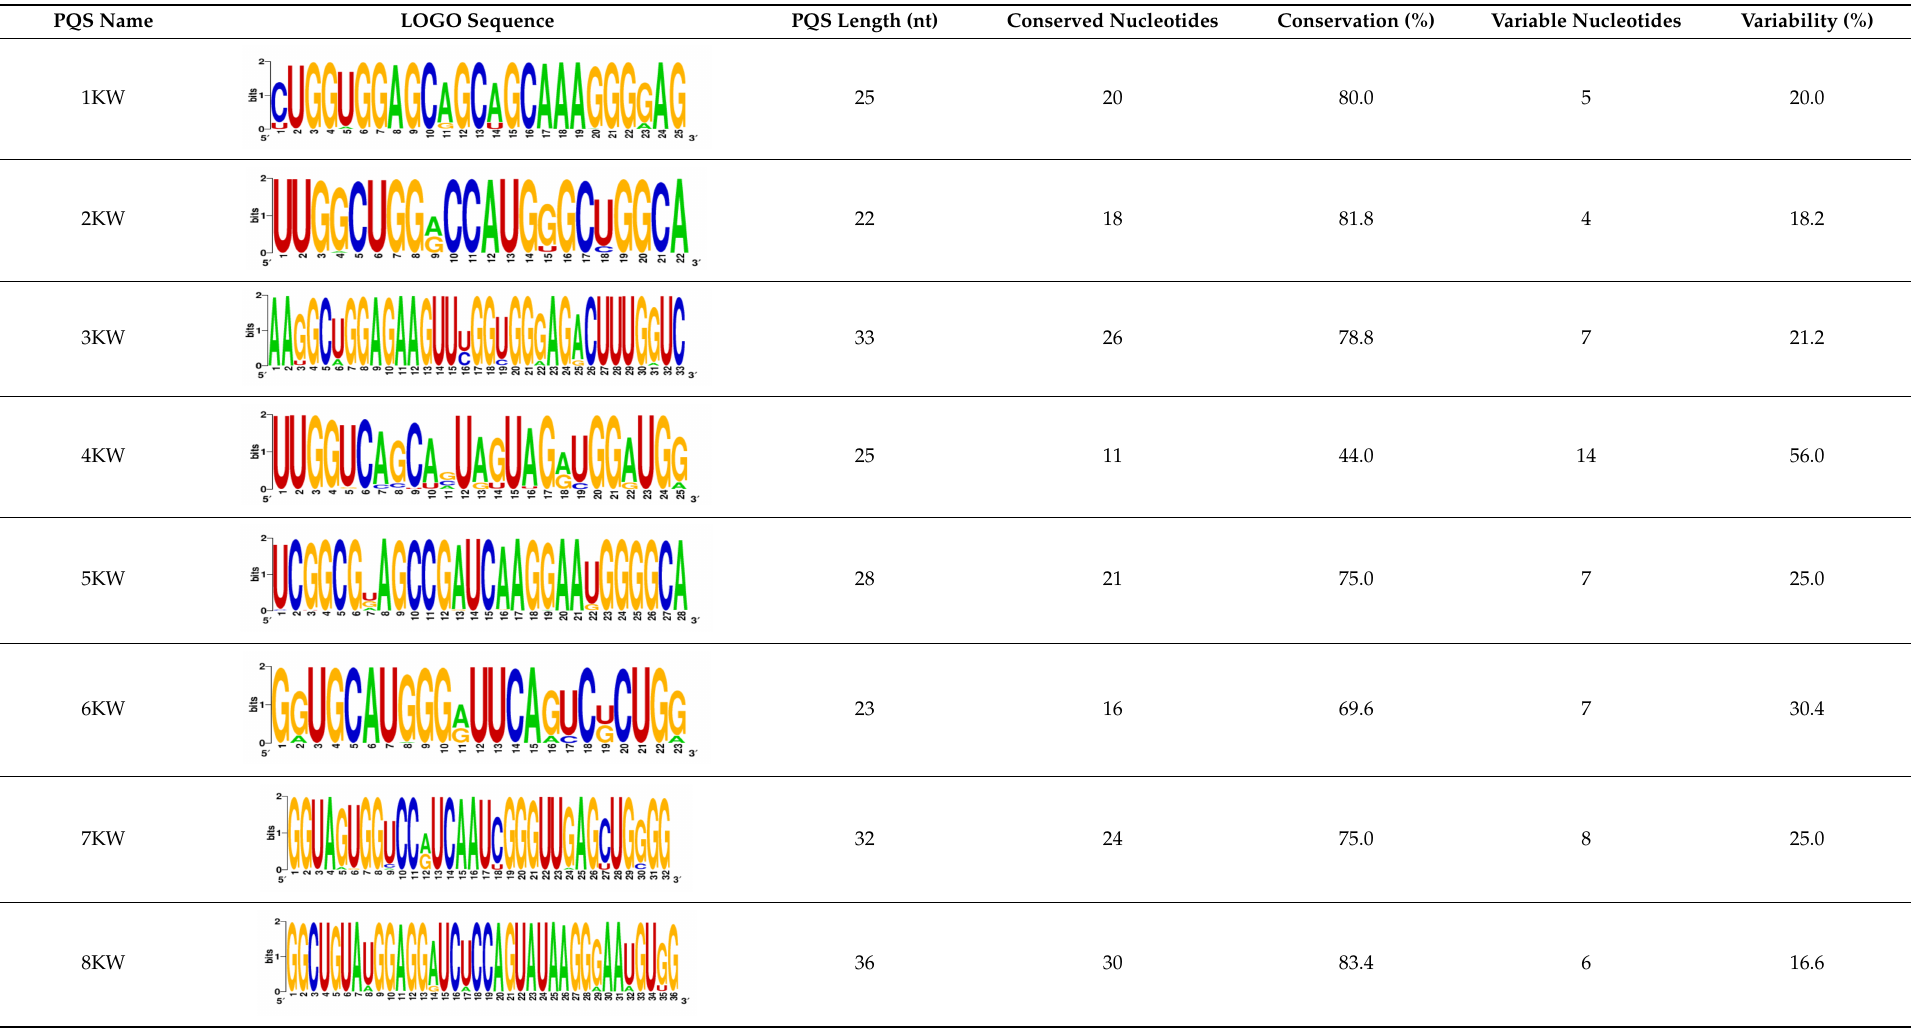
Table 3. PQS motifs presented as LOGO sequences, their conservation and variability